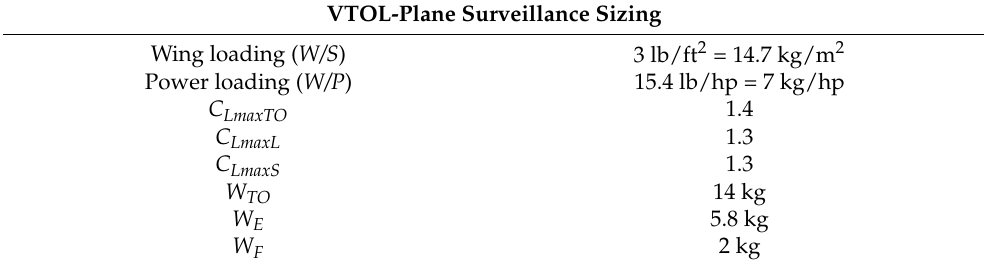
Figure 2. Performance sizing chart. Table 3. Performance sizing.